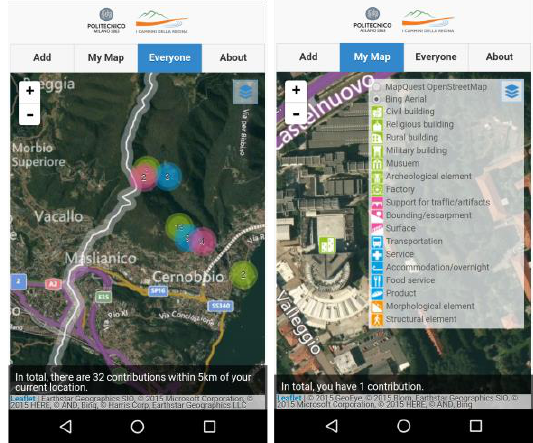
Figure 5. All POIs aggregated based on their category (left) and the legend (right)